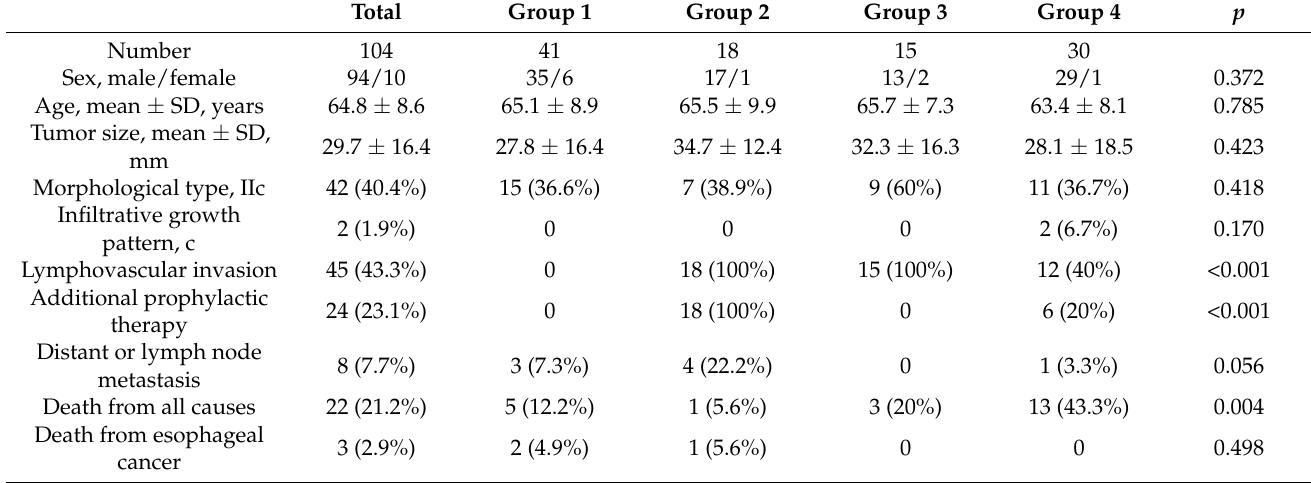
Table 1. The baseline characteristics of patients who received ER for superficial pT1a-MM